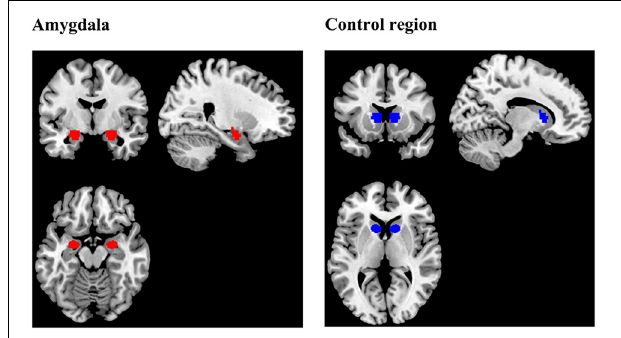
FIGURE 2 | Regions of interest (ROIs) for the extraction of the neurofeedback signal during training. The amygdala mask was prepared using the Talairach Daemon (Lancaster et al., 2000) and included voxels which were exclusively assigned to the amygdala by the online tool. The mask delineating the control region was the same size and shape as the amygdala mask, but was located in another part of the brain, comprising parts of rostral basal ganglia, and white